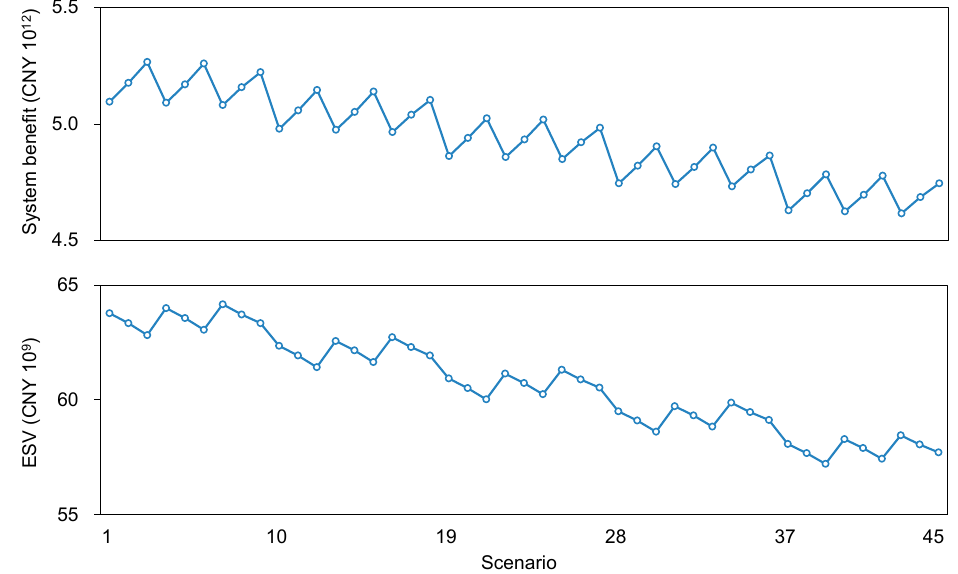
Figure 10. The system bene fi t and total ESV under di ff erent scenarios.